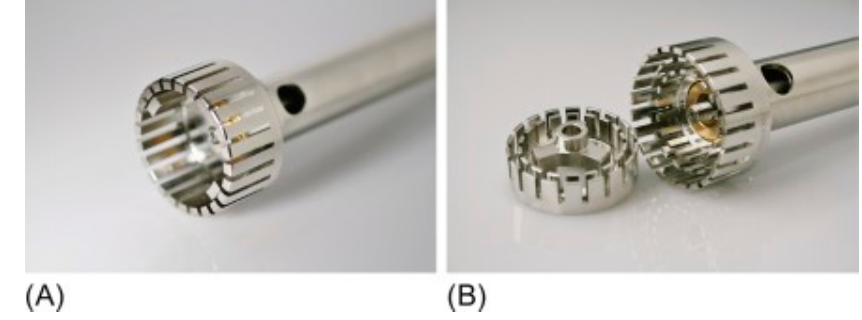
Figure 3. High shear rotor-stator system ( A ), and its parts ( B ) [16].